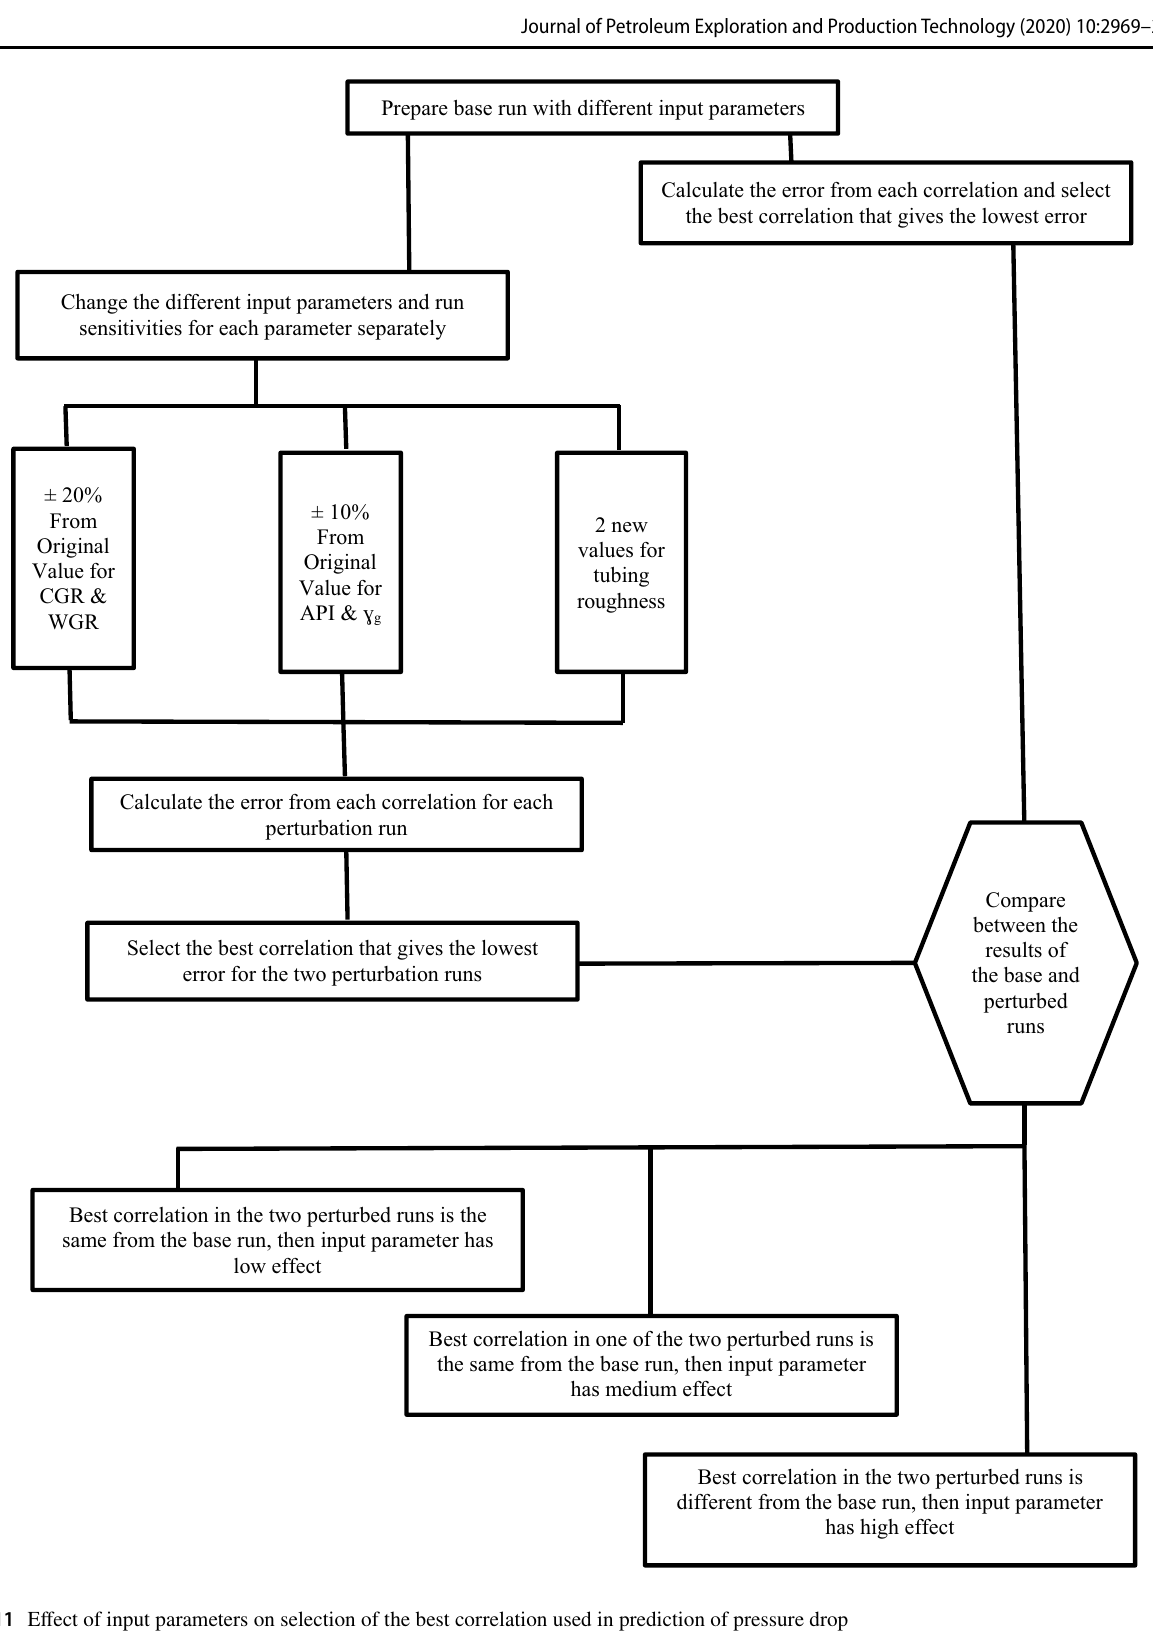
Fig. 11 Effect of input parameters on selection of the best correlation used in prediction of pressure